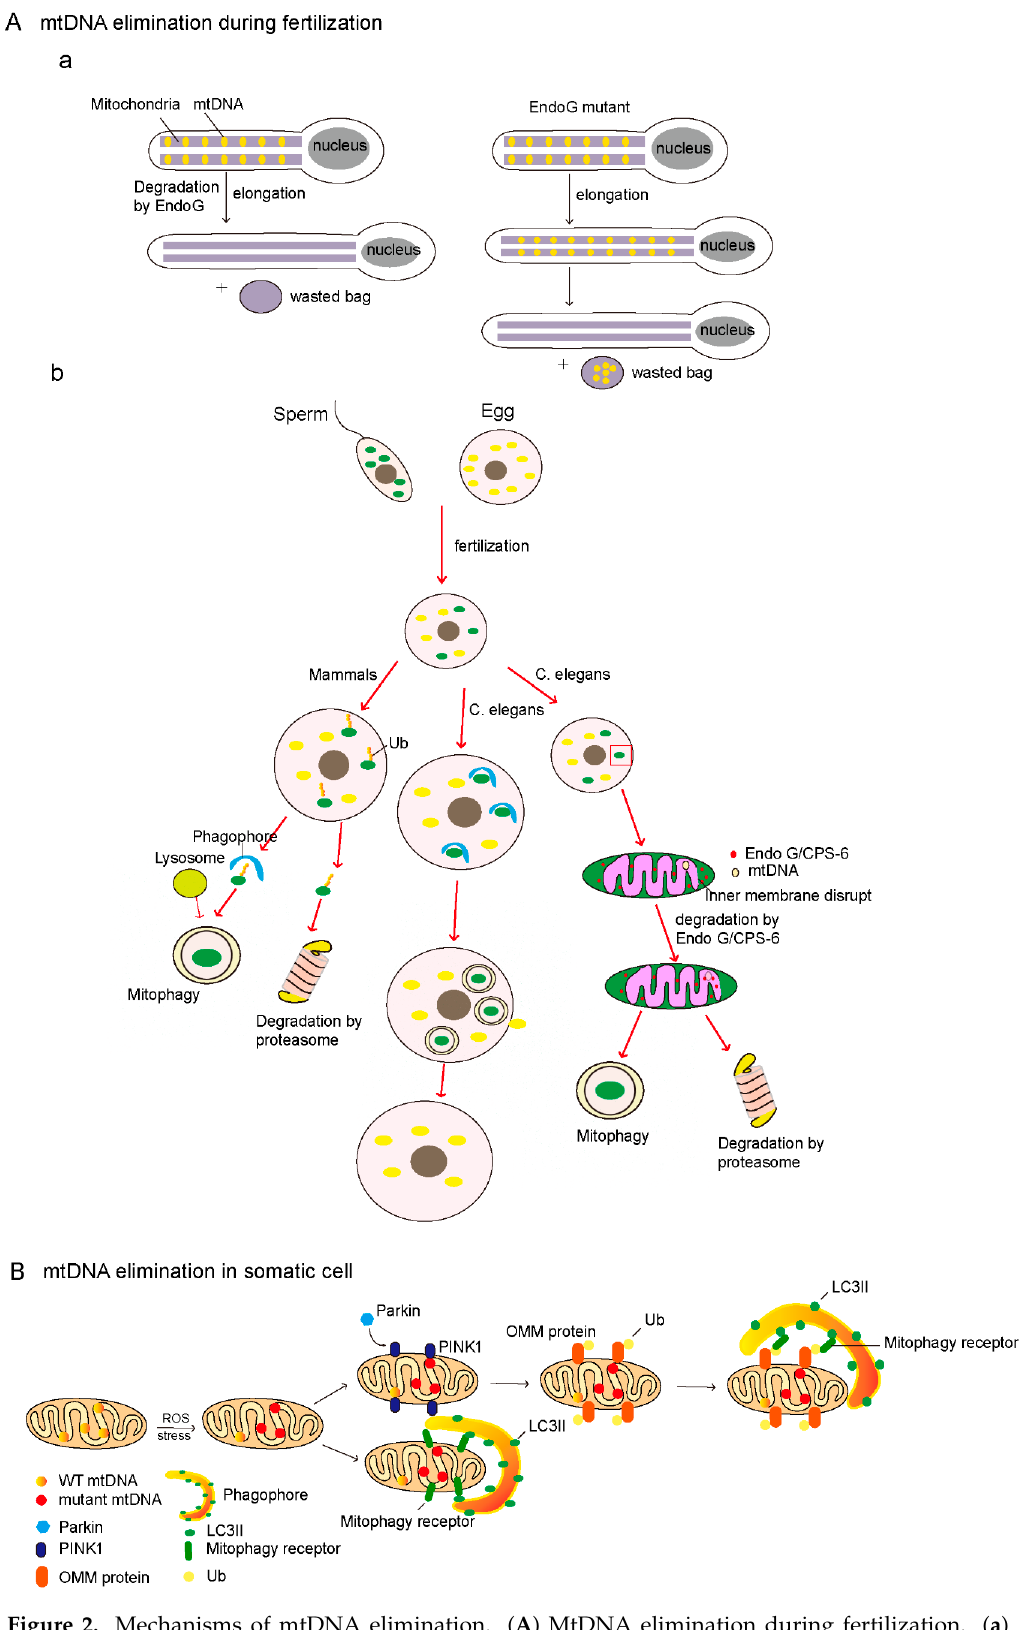
Figure 2. Mechanisms of mtDNA elimination. ( A ) MtDNA elimination during fertilization. ( a ) Mechanism of mtDNA elimination in Drosophila melanogaster . Pre-fertilization, the mtDNA of sperm in flies are deleted by endonuclease G (EndoG) during sperm elongation, as shown on the left. In the